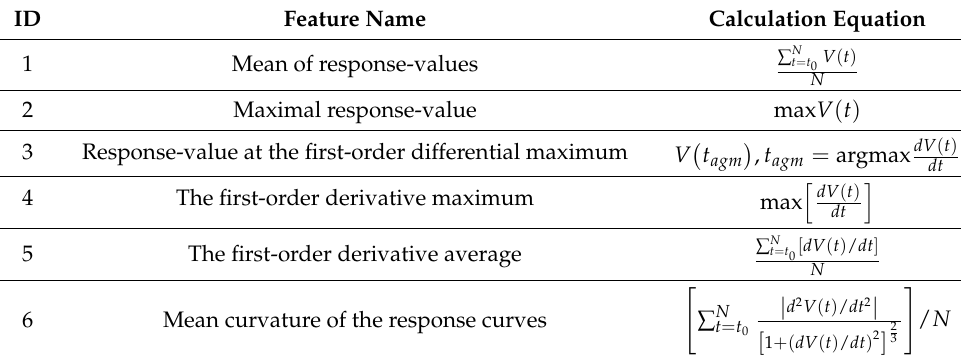
Table 1. The six equations used to extract features from the preprocessed